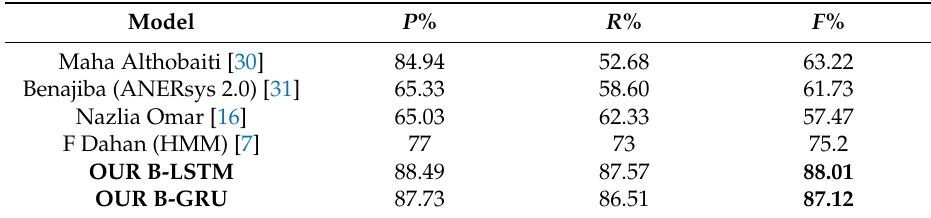
Table 2. Comparison of F-score performance measure of the proposed models concerning the baseline systems on